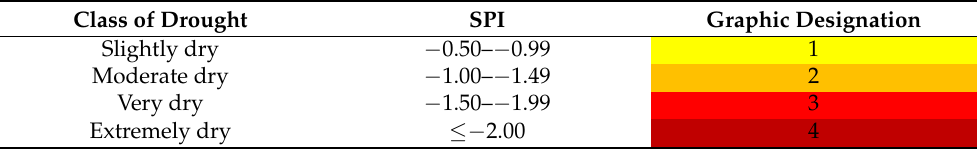
Table 1. Meteorological drought classes according to the standardized precipitation index (SPI)